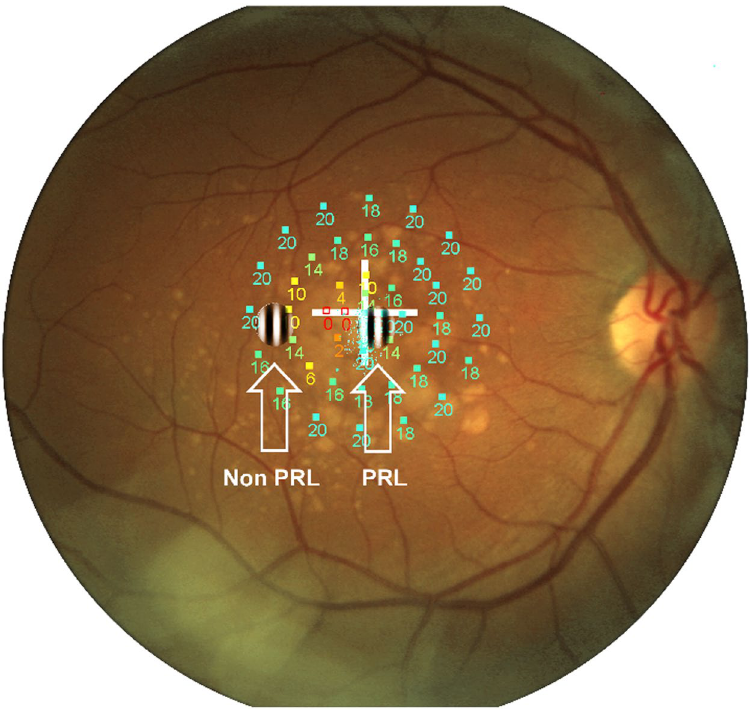
Figure 1. Illustrative example of stimuli placement. Stimuli presented at the PRL and at the non-PRL are superimposed over the Eye movement recording. Participants’ fixation was controlled with an eye tracker to determine the retinal position corresponding to the patients’ PRL/non-PRL and to be sure that fixation was maintained. Calibration and recording procedures were as follows. Eye movements were recorded using a Mirametrix S2 eye tracker with